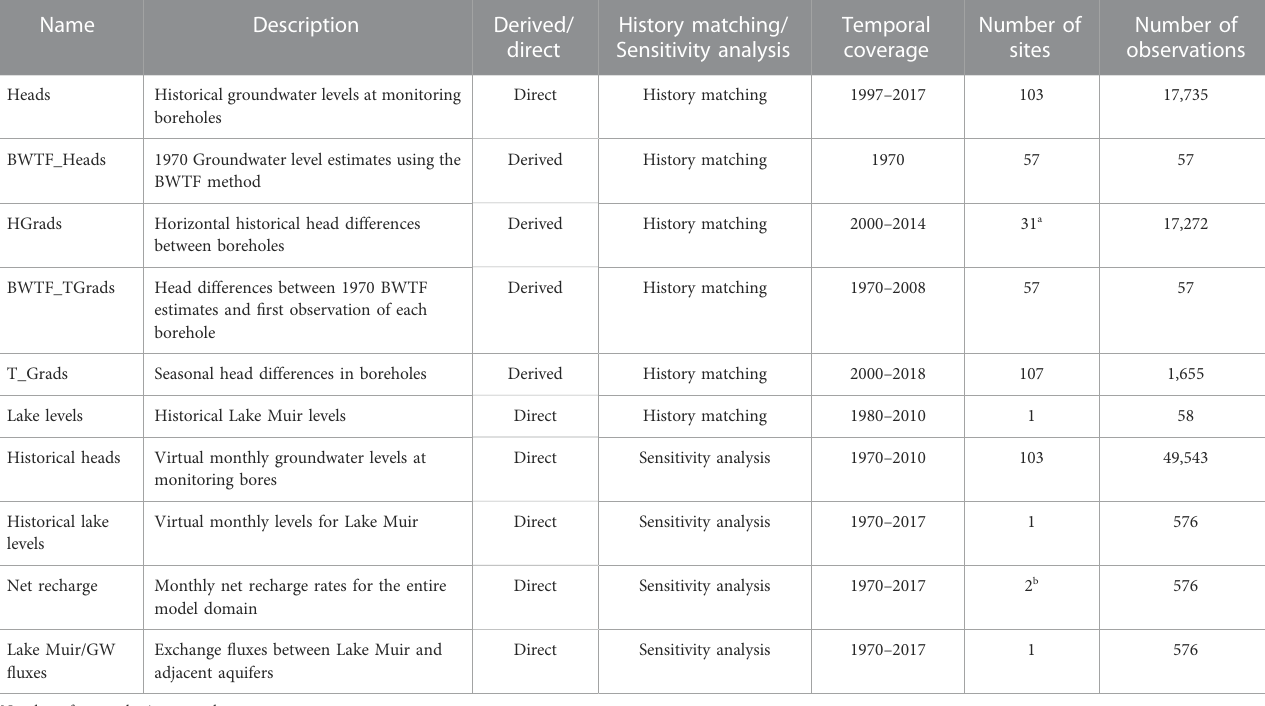
TABLE 3 System observation metrics used in history matching, and predictive metrics used in the UQ and SA work fl ows.